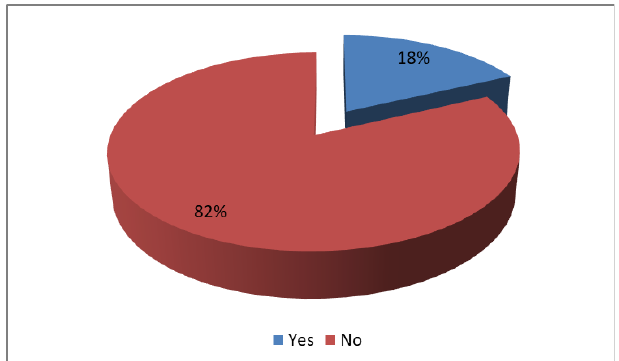
Figure 4: Do you consider the candidate’s gender to be relevant in the political ascension? Data source: the